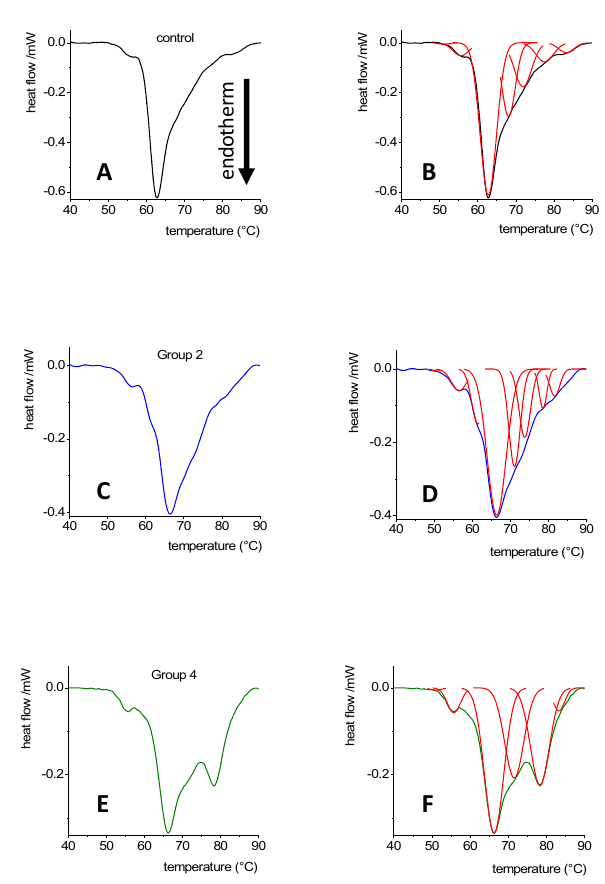
Figure 2. DSC curves [33,36,37] and their deconvolution in case of blood plasma from control individuals ( A , B ) ( n = 10), and from breast cancer patients ( n = 19), where the tumor diameter was between 11 and 20 mm in Group2 ( C , D ), and was doubled in size between 31 to 40 mm in Group4 ( E , F ). Patients only belonged to two groups. In Group 2 (Gr2), the tumor diameter was between 11 and 20 mm, while in Group 4 (Gr4) it ranged between 31 and 40 mm. Ten healthy controls and 19 females with verified breast carcinoma were involved in this study (median age 55.4